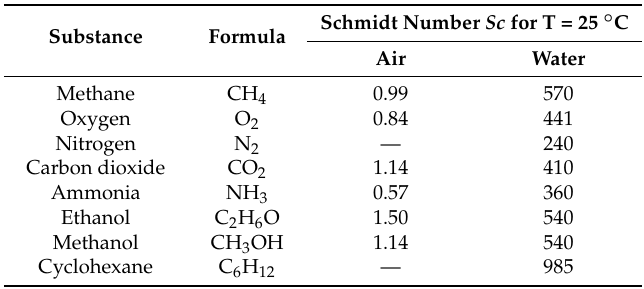
Table 1. Values of the Schmidt number for different substances in air and